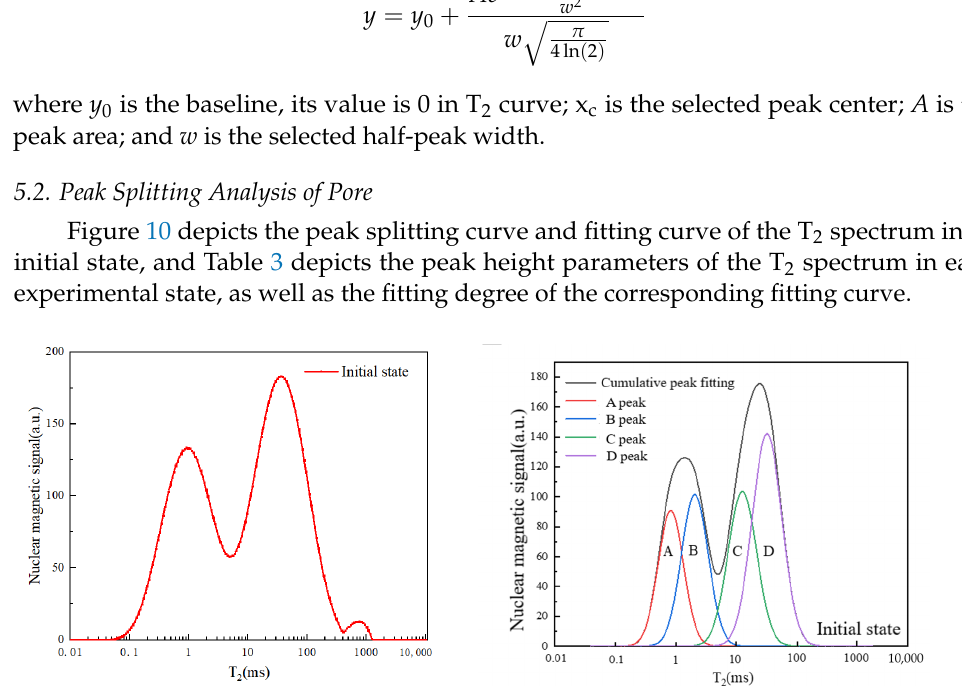
Figure 10. Initial T 2 spectrum and peak splitting results before freeze–thaw cycles.